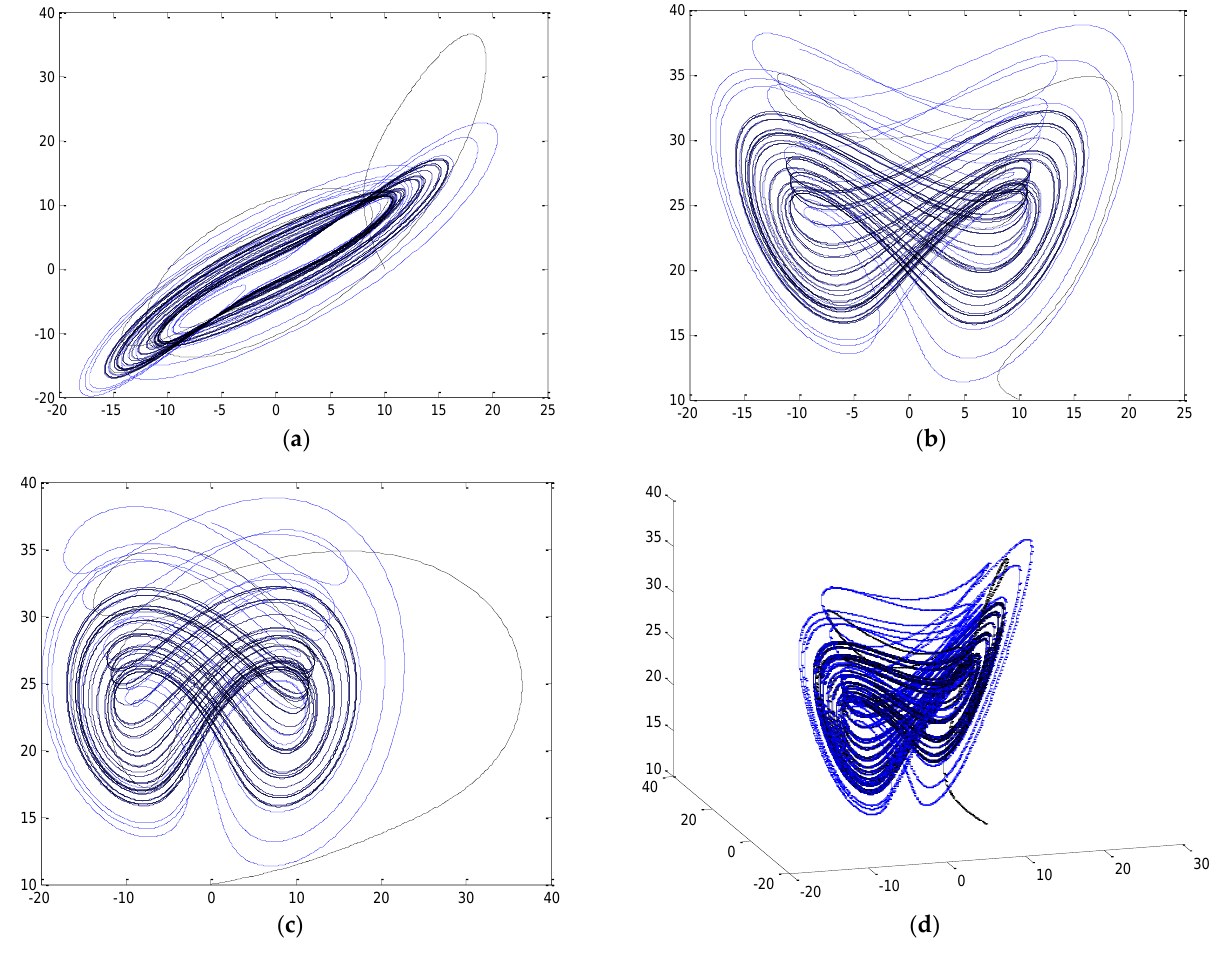
Figure 5. The phase portraits for the synchronization between Chen (Black Line) and time-delay Lorenz chaotic systems (Blue Line) with 𝛼 = 0.9 and time delay 𝜏 = 5 s: ( a ) On (𝑥 − 𝑦,𝑥 1 − 𝑥 2 ) phase plane; ( b ) on (𝑥 − 𝑧,𝑥 1 − 𝑥 3 ) phase plane; ( c ) on (𝑦 − 𝑧,𝑥 2 − 𝑥 3 ) phase plane; ( d ) on (𝑥 − 𝑦 − 𝑧,𝑥 1 − 𝑥 2 − 𝑥 3 ) space.